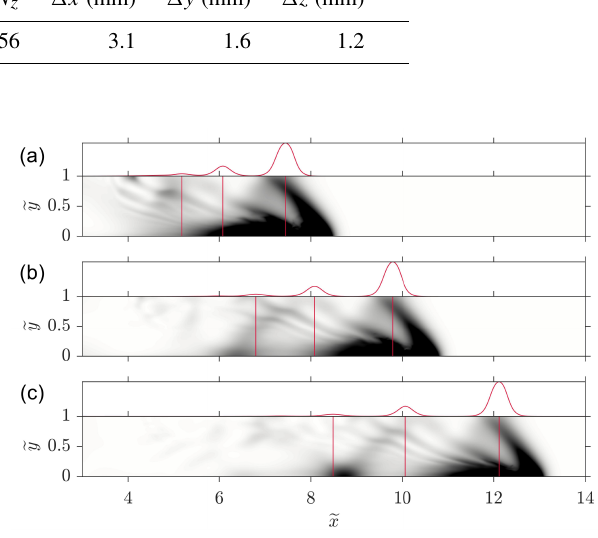
Figure 4. Scaled, vertically integrated kinetic energy, ξ , for case 10_1 at t = (a) e t = 4 . 7 (t = 45s ) , (b) e t = 6 . 3 (t = 60s ) , and (c) e t = 7 . 8 (t = 75s ) . The scaling and colour axis is identical to Fig. 2. The red plots are the span-wise average ξ profiles for the non-rotating case (case 10_0), with corresponding maxima locations (vertical Figure 3. Scaled, vertically integrated kinetic energy, ξ , at e t = 10 . 4 (t = 100s ) for the case with Sc = 10 and (a) f/f 0 = 0 ( Ro = ∞ ), (b) f/f = 1 / 4 ( Ro = 5 . 9), (c) f/f = 1 / 2 ( Ro = 2 . 91), and 0 0 (d) f/f 0 = 1 ( Ro = 1 . 46). The scaling is by the maximum over the f = f 0 case and the colour axis is saturated to emphasize the Poincaré waves emanating from the focusing region and their re- flection off the e y = 1 wall. The maximum of the unscaled ξ for each case is (a) 0.08Jm, (b) 0.12Jm, (c) 0.16Jm, and (d) 0.27Jm. Though in non-dimensional form, the axes have correct dimensional scaling.